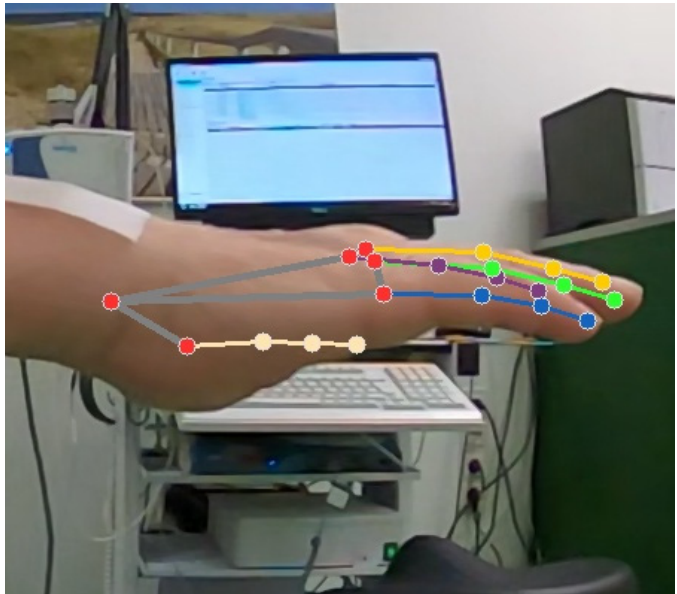
Figure 4. Example landmarks extraction process (the thumb is not visible in the video, but landmark positions are estimated (beige: thumb, lilac: index finger, yellow: middle finger, green: ring finger, blue: little finger, red: wrist, carpometacarpal and metacarpophalangeal joints).